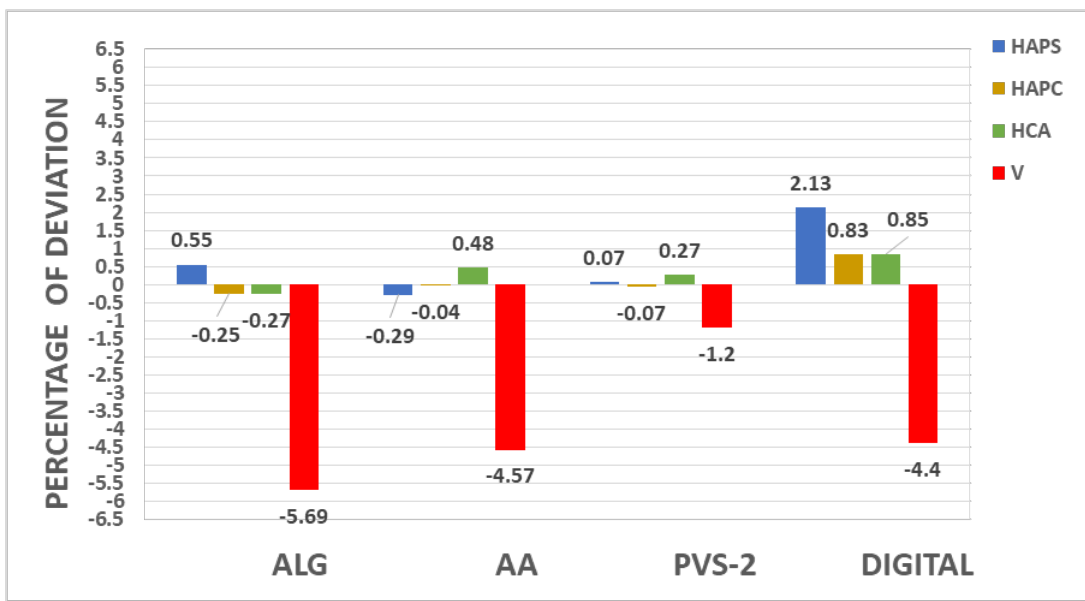
Figure 6. Percentage of deviation from the typodont master cast for impression materials and digital models. ALG, alginate; AA, alginate alternative; PVS-2, two-step putty–light body polyvinyl siloxane; HAPS, horizontal anteroposterior straight; HAPC, horizontal anteroposterior curved; HCA, horizontal cross-arch; V, vertical.